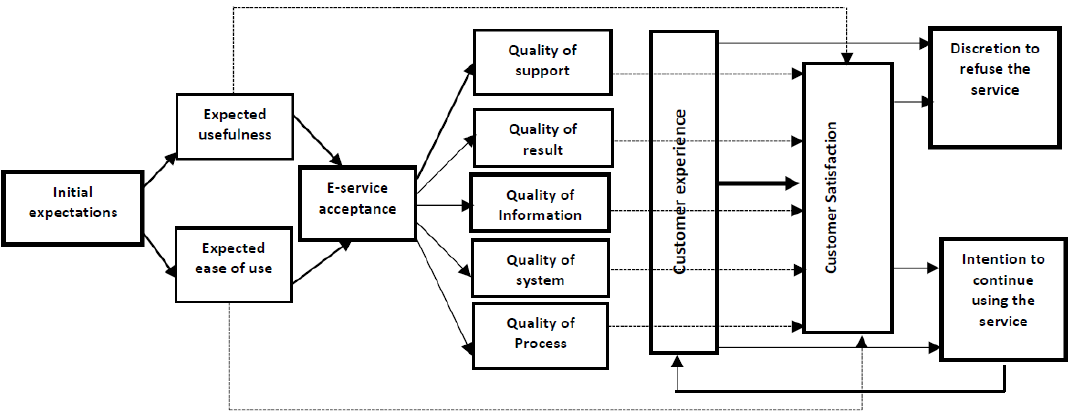
Figure 3. The revisited integrated e-service adoption–continuance quality model.